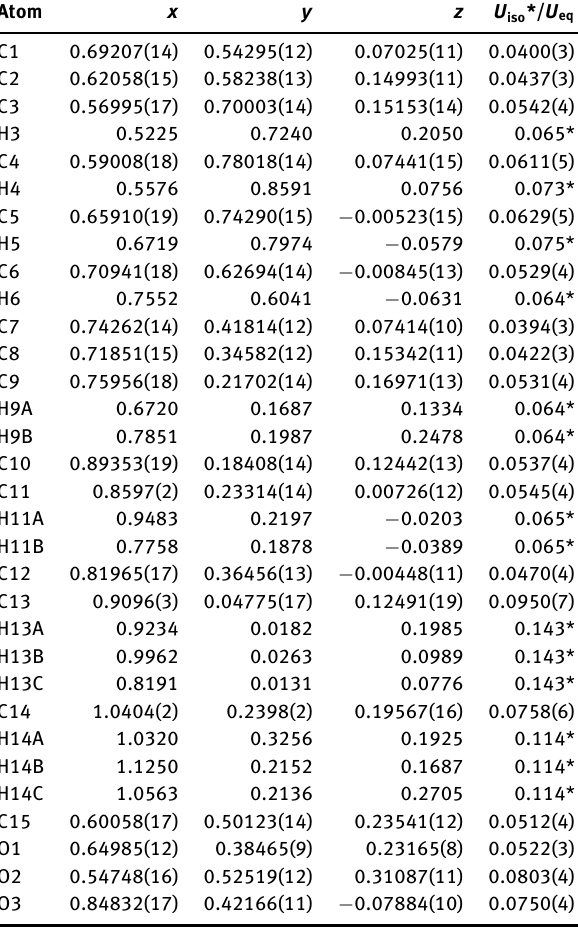
Table 2: Fractional atomic coordinates and isotropic or equivalent isotropic displacement parameters (Å 2